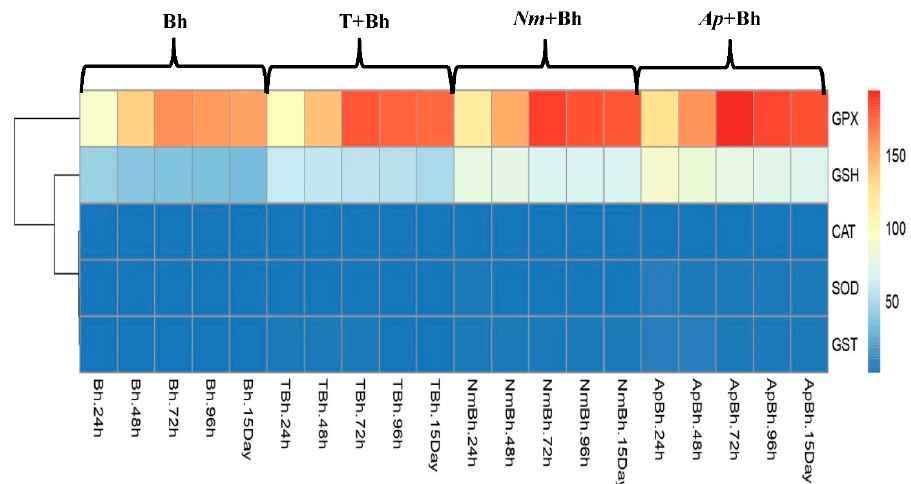
Figure 2. Heat map showing expression patterns of the differential expressed antioxidant-related enzymes as a response to Bh application alone or in combination with different safener treatments on wheat plants at the vegetation stage. The transcript abundance level is shown in the color legend, where red specifies the transcripts with a higher level, and blue specifies transcripts with a lower level. Bh: bromoxynil; T + Bh: tryptophan + bromoxynil; Nm + Bh: Nostoc muscorum + bromoxynil; Ap + Bh: Arthrospia platensis + bromoxynil. Table 2. Effect of Bh application alone or in combination with different safener treatments on the activity of antioxidant enzymes *. Treatment